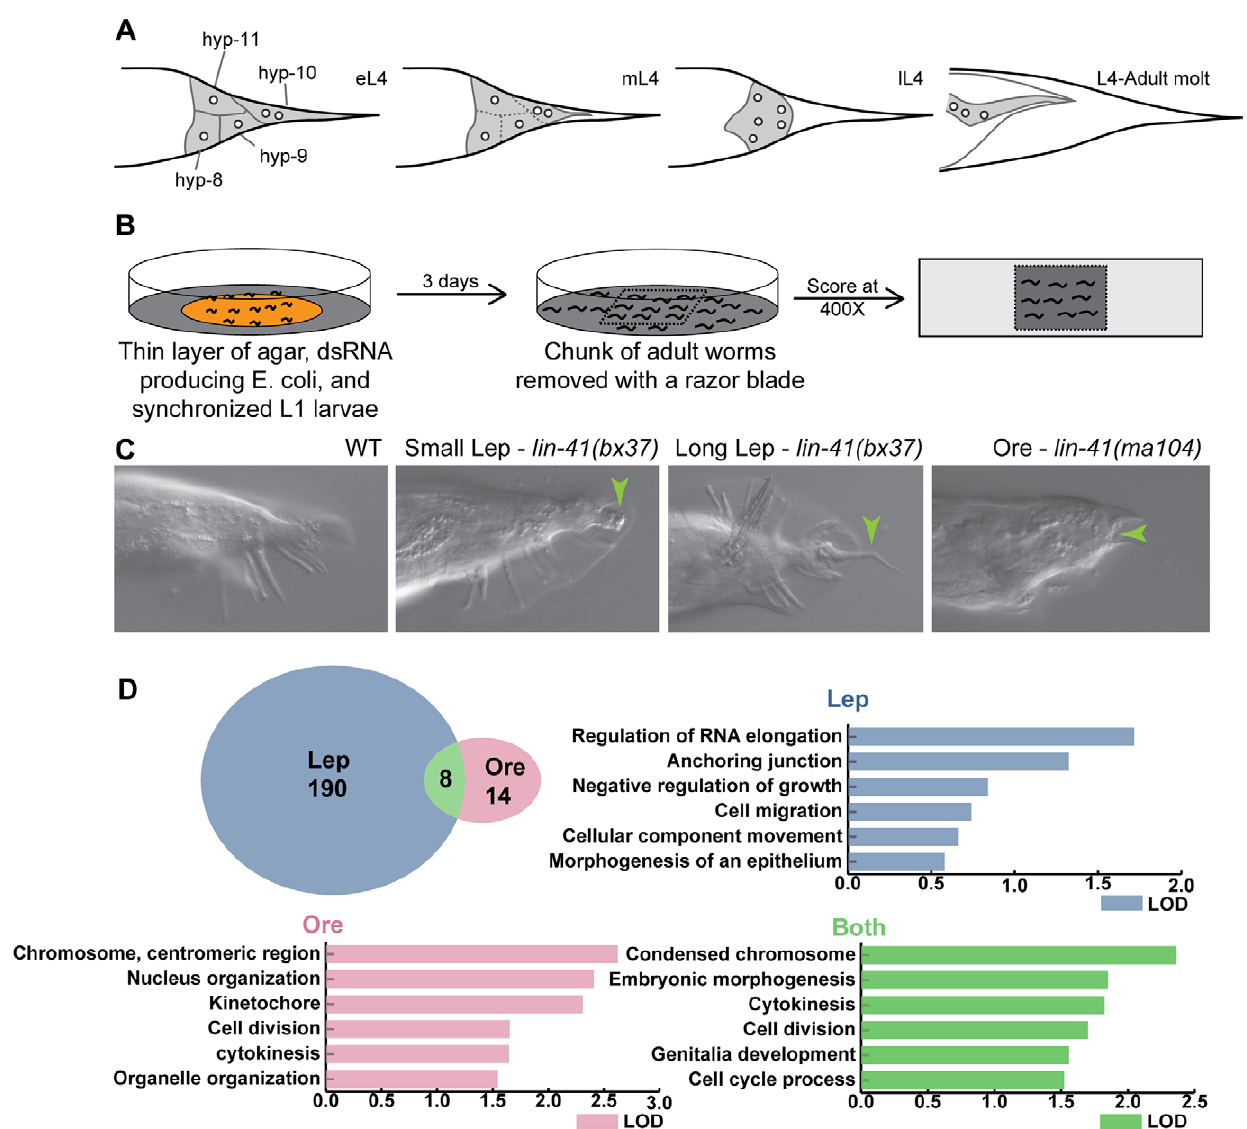
Figure 1. Overview of tail tip morphogenesis and the experimental design for the genome-wide RNAi screen for tail tip defects in male C.elegans . (A) Schematic of tail tip morphogenesis: the tail tip cells hyp8–hyp11 fuse and then detach from the overlying cuticle. The newly formed syncytium changes shape—becoming rounded—and migrates anteriorly. By the adult stage, the male tail has flattened out ventrally. (B) Screening methodology: L1 larvae were fed dsRNA-producing bacteria on thin films of nutrient agar and grown to adulthood. A square of agar containing worms was mounted on a slide and scored at 400 6 magnification. (C) The phenotypes scored included WT (wild type), Lep (leptoderan), and Ore (over-retracted). Additional phenotypes scored but not reported here were spicule morphology and general male tail defects (see http:// wormtails.bio.nyu.edu). (D) Distribution of the phenotypes among the 212 positive genes; for 8 genes, Lep and Ore tails were observed in the same experiment. GO attribute enrichment via FuncAssociate [29] for genes causing Lep, Ore and Lep + Ore phenotypes upon RNAi. For each phenotype, the top six categories that were over-represented are indicated with bar graphs depicting the LOD scores, i.e. the log of the odds that the frequency of a GO category is no different than that for all genes in the genome.